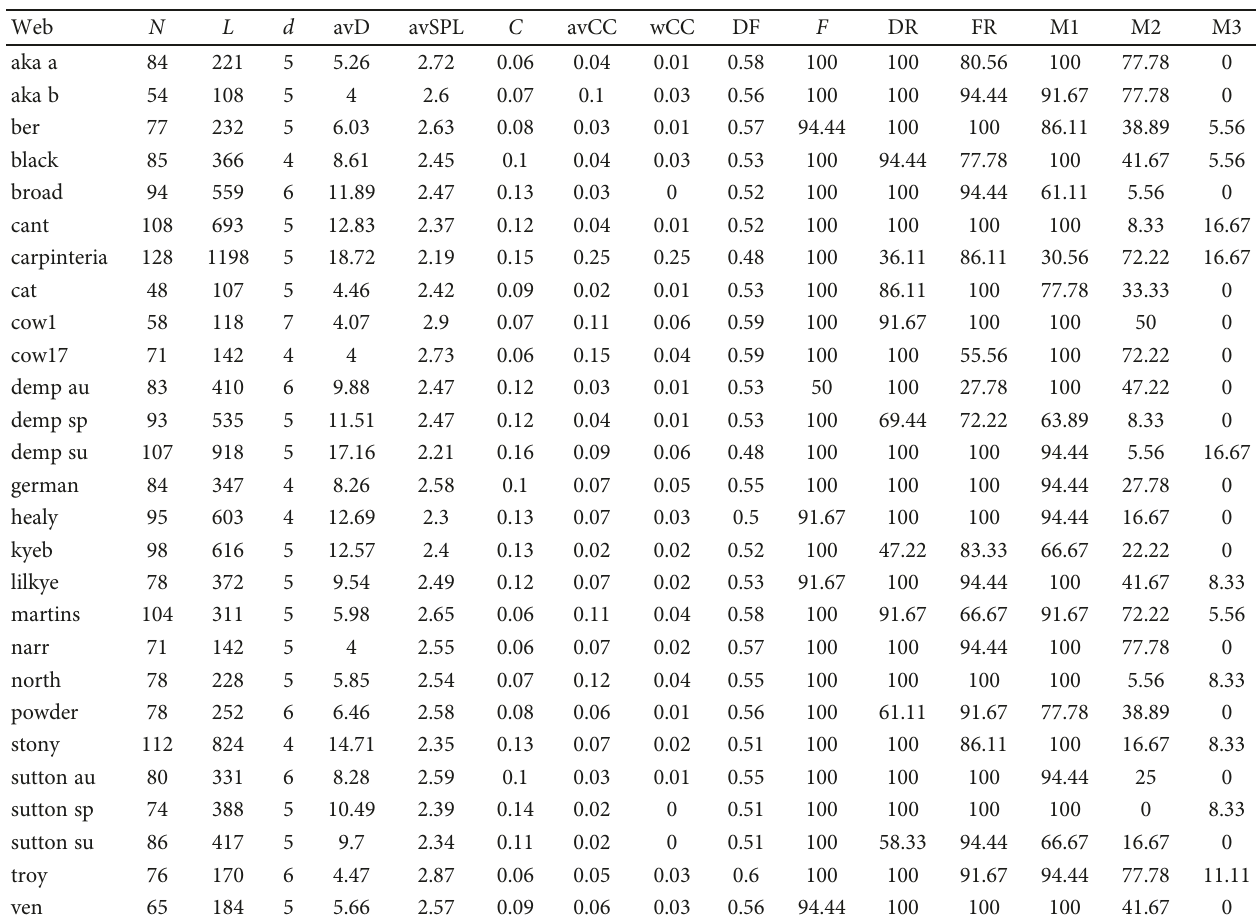
Table 1: Topological properties and nestedness of multinode centrality sets for 27 food webs. The topological properties include the number of nodes ( N ), the number of edges ( L ), diameter ( d ), average degree (avD), average shortest path length (avSPL), connectance ( C ), average clustering coe ffi cient (avCC), weighted clustering coe ffi cient (wCC), and distance-based fragmentation (DF). Nestedness is always calculated for sets of n = 1 to 4 nodes, based on fragmentation ( F ), distance-based fragmentation (FR), weighted reachability (DR),